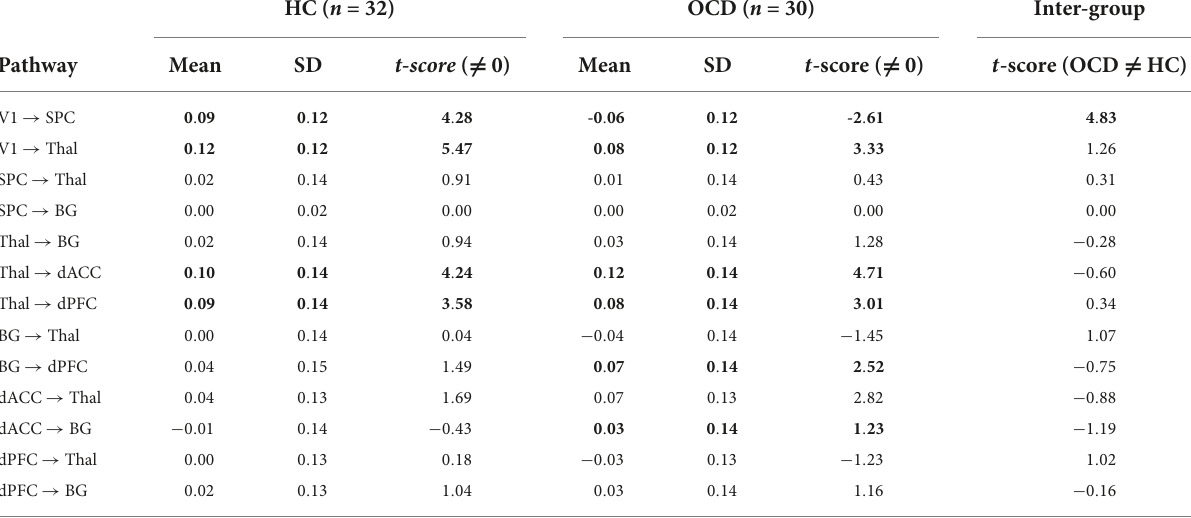
TABLE 2 Intrinsic connectivity parameters and statistical analyses (significant effects in